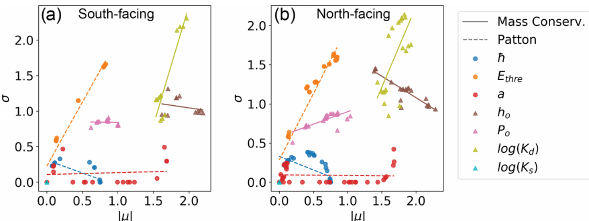
Figure 3. Sensitivity analysis of the seven parameters in the hybrid model. Parameters h , E thre , and a are in Patton’s method and h o , B p , log( K d ), and log( K s ) are in the mass conservation method. The solid and dashed lines are fitted linear-regression lines to reveal the relationship between the standard deviation ( σ ) of the elementary effect and the absolute of the mean ( | µ | ) of the elementary effect for the mass conservation method and Patton’s method, respectively. Each dot is at one sampling location per